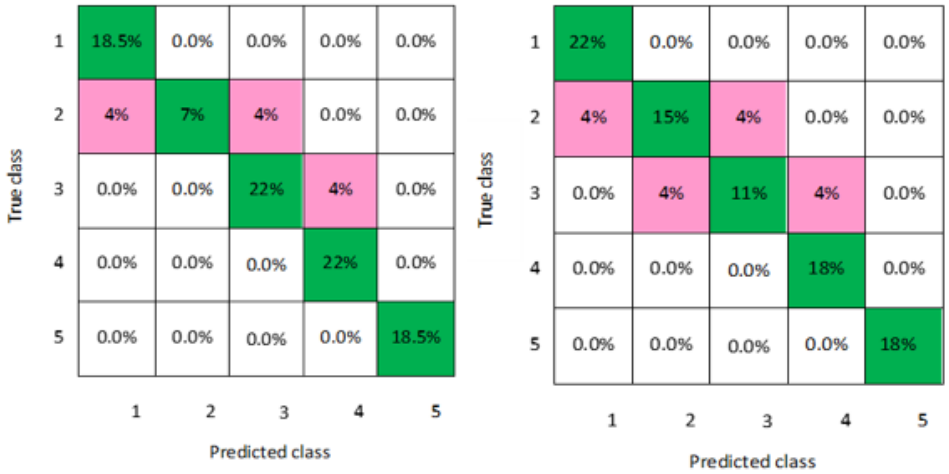
Figure 2. LD model confusion matrixes for men and women data, respectively.